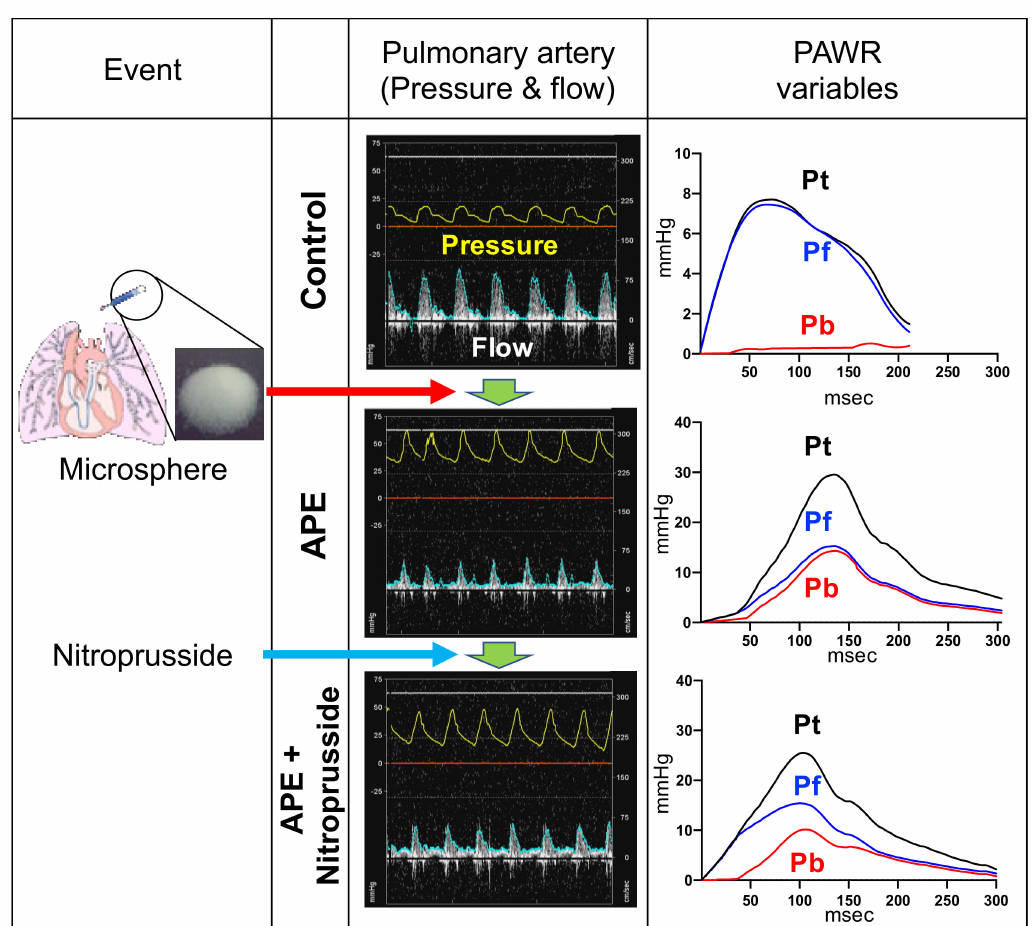
Figure 1. Schematic representation of the used procedures to evaluate pulmonary artery wave reflection (PAWR) wave variables (Pt, total pressure; Pf, forward-traveling pressure; Pb, backward-traveling pressure) after induction of acute pulmonary embolism (APE) in the dog model. The PAWR variables were evaluated at the baseline after anesthesia induction (control), after injection of Dextran microspheres to induce APE and later after administration of nitroprusside to induce